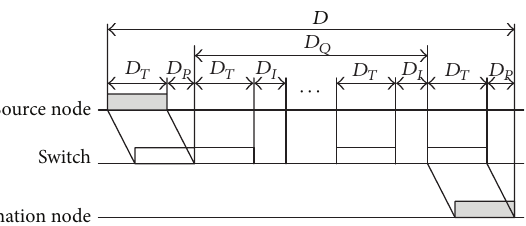
Figure 2: The hierarchical structure of switched Ethernet.